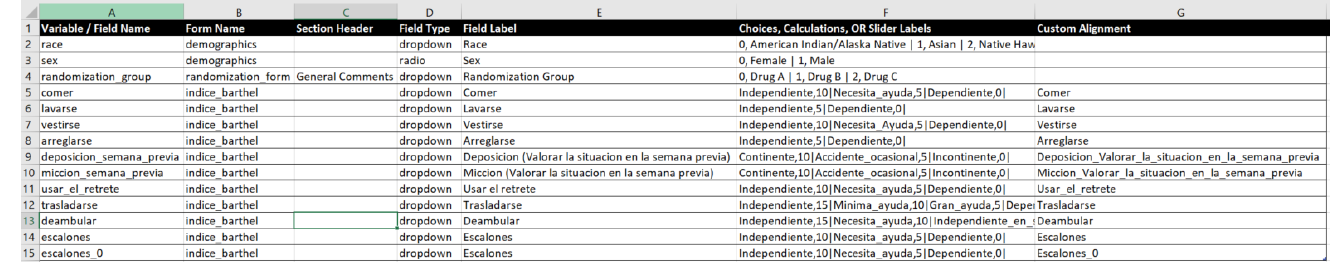
Figure A3. RedCap. Figure A3. RedCap.